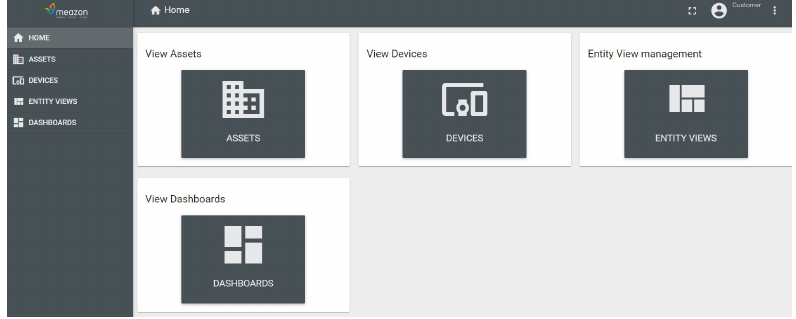
Figure 3. Home view.